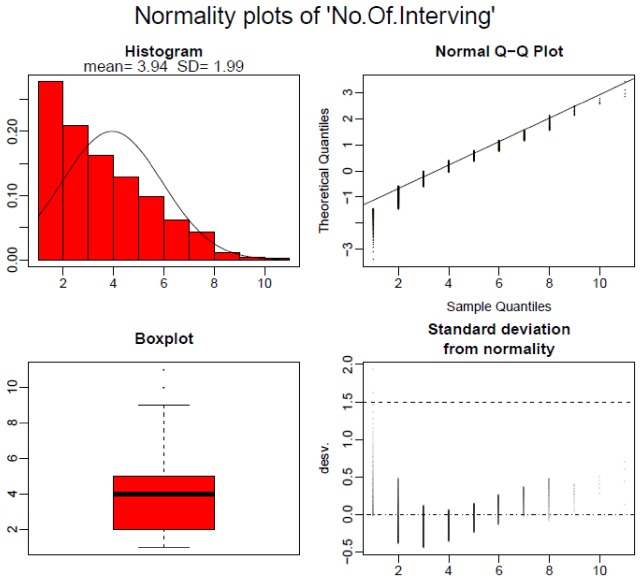
Distribution for the quantitative variable Number of Intervening. Shapiro–Wilks p-value: <001.